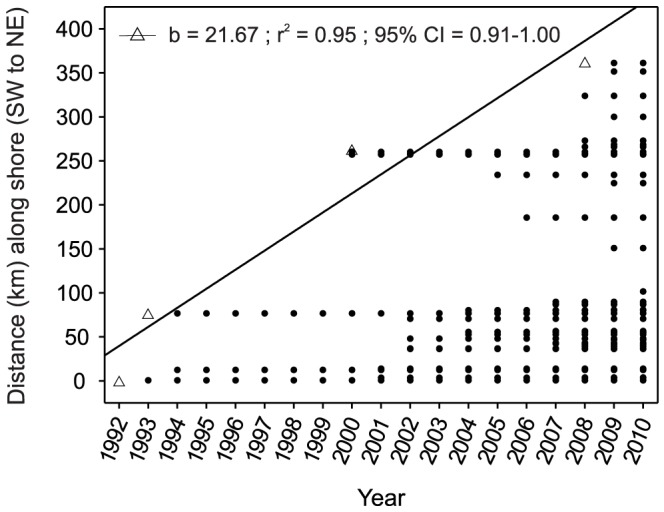

Oculina patagonica records obtained on the Catalan coast throughout the study period (1992–2010).Records of the coral occurrence (full circles) throughout the Catalan coastal length (km) from 1992–2010 illustrate the spreading of the species over time. Blank triangles indicate the change in the northern latitudinal limit over time. The expansion rate (km year−1) was calculated as the slope of the Pearson product-moment correlation between the change in the northern latitudinal limit of the coral species and time (n = 4). 95% CI: 95% confidence interval calculated with bootstrapping.